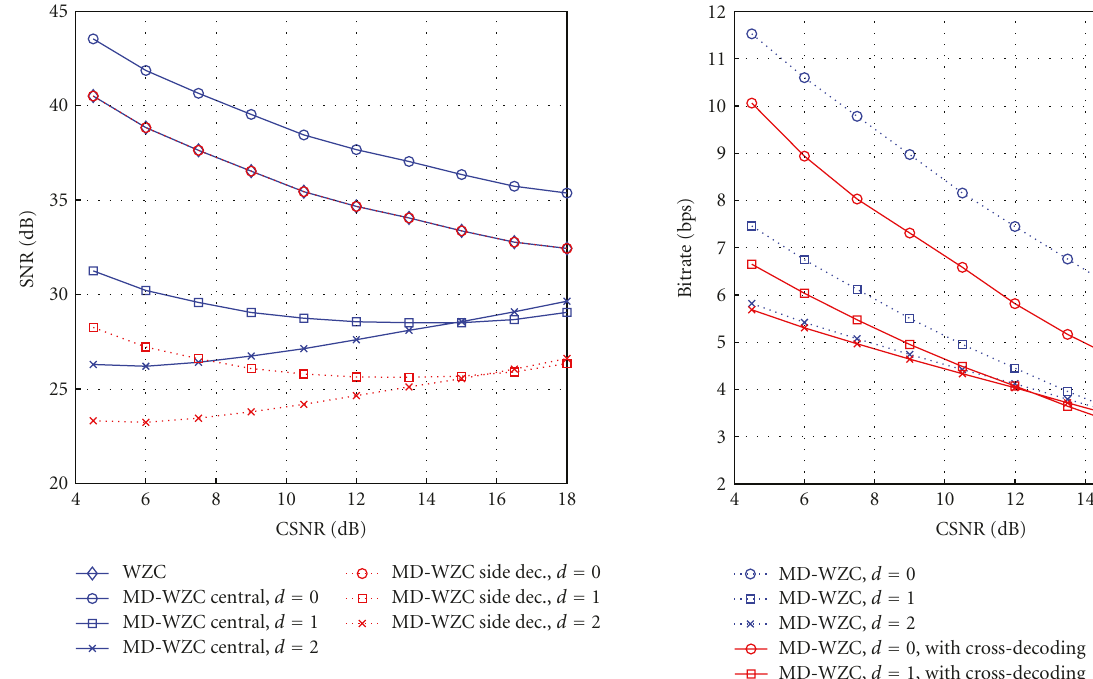
Figure 9: Achievable SNR of the WZC and MD-WZC schemes. d = 2 where the SNR can gain up to 12 dB when going from a CSNR value of 4.5 dB to 18 dB.